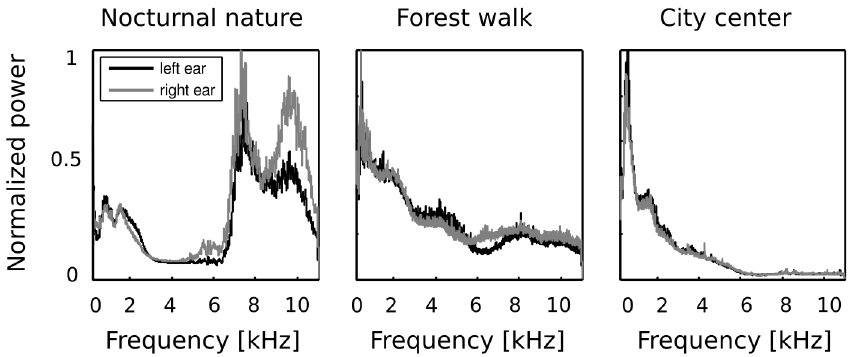
Figure 2. Frequency spectra of binaural recordings. In the forest walk and the city center scenes spectra of sounds in the left and in the right ear (black and gray lines respectively) were approximately the same. In the nocturnal nature scene, a sound source was constantly present on the right side of the head, therefore more power was present in high frequencies in the right ear.